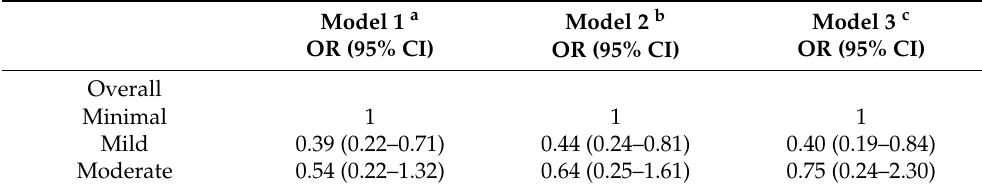
Table 3. Adjusted odds ratios (95% confidence interval) for prevalence of weekly sexual activity in relation to anxiety levels (reference subgroup: